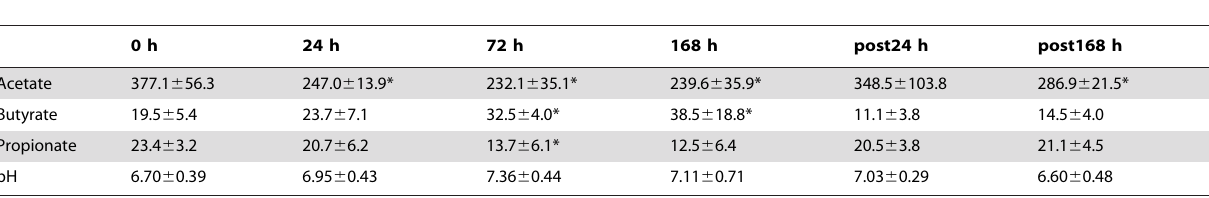
Table 1. The ruminal pH and volatile fatty acid concentrations (mM) in response to butyrate